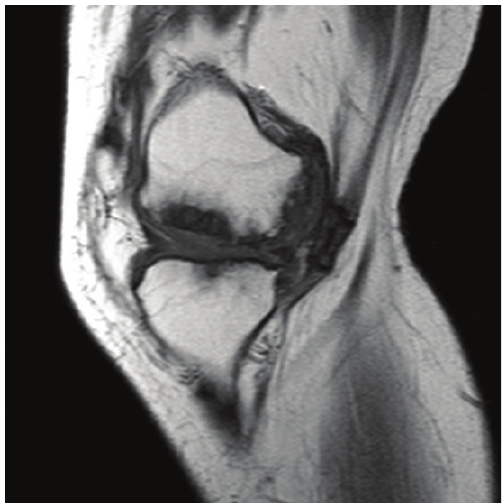
Figure 9: MRI T1 sagittal view of the right knee.